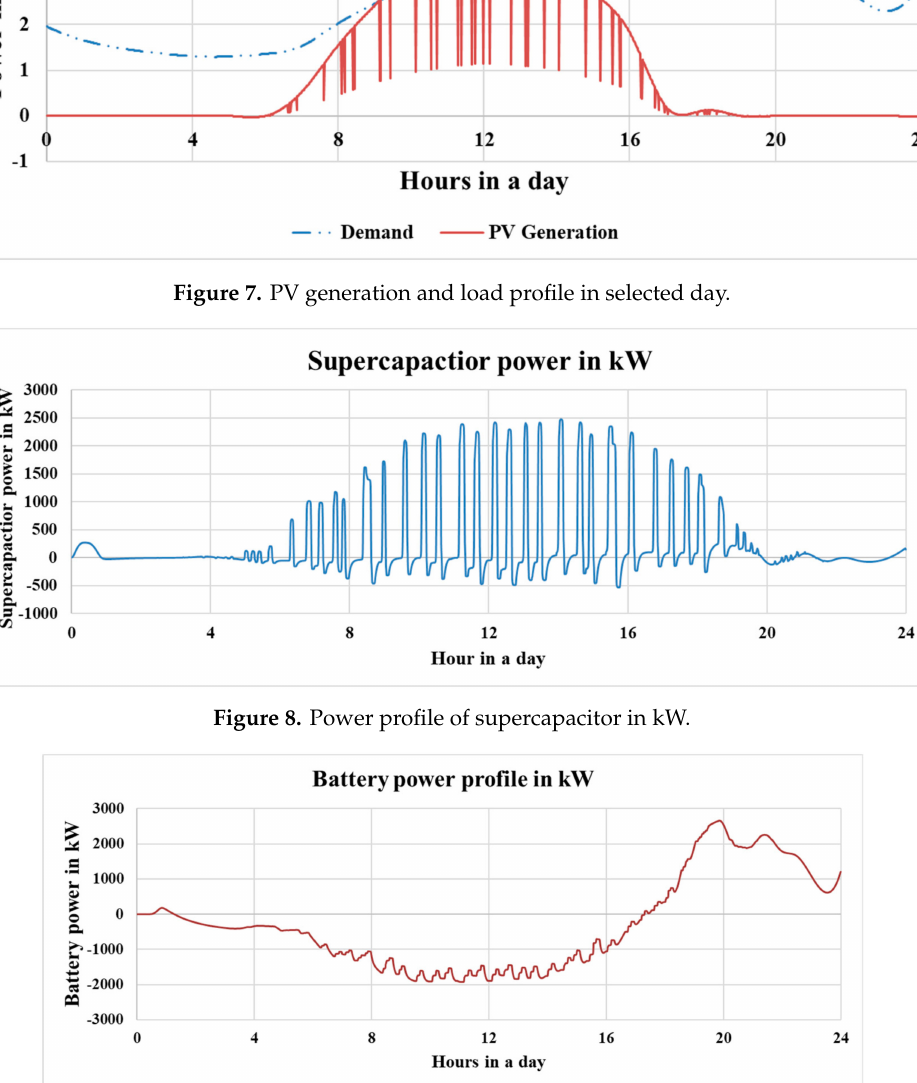
Figure 9. Power profile of battery in